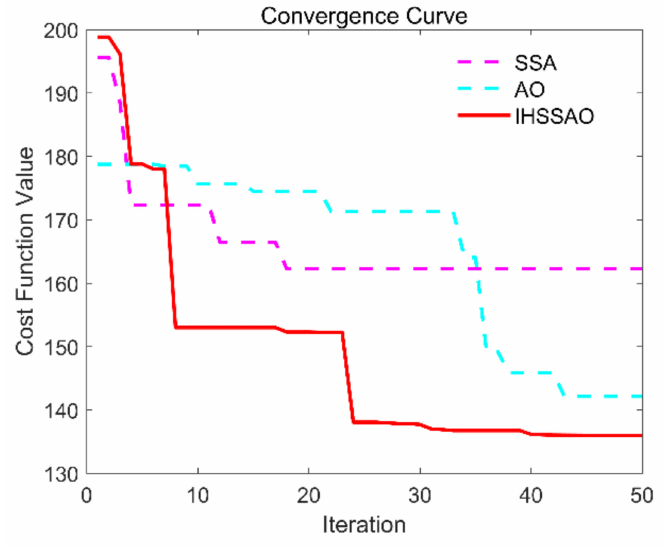
Figure 11. The convergence cures of the SSA, AO, and